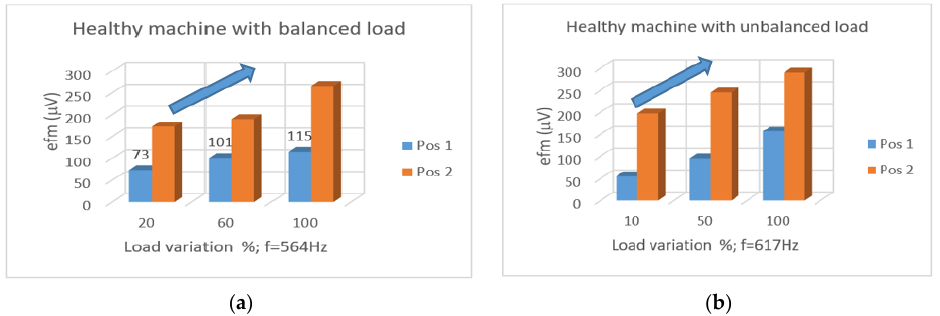
Figure 17. Amplitude variation for SEIG harmonic components at load variation: ( a ) healthy machine with balanced resistive load, ( b ) healthy machine with unbalanced resistive load.